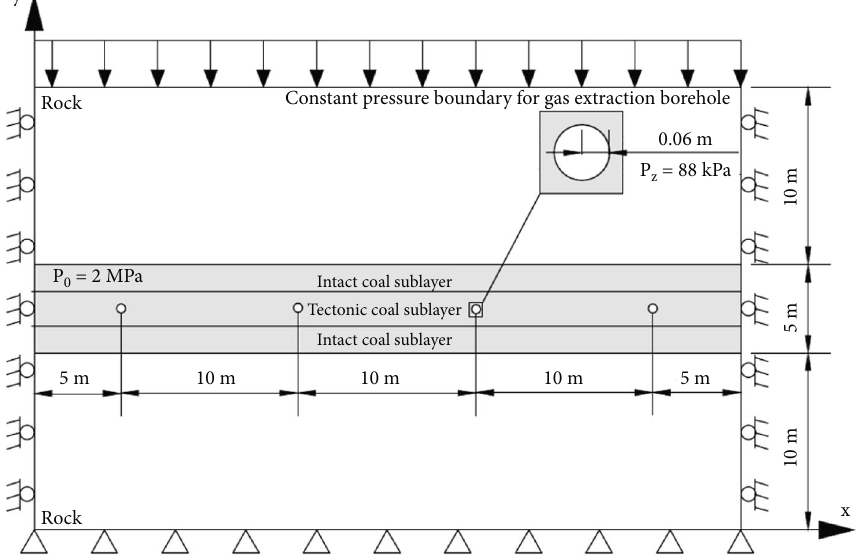
Figure 2: Geometry for gas migration in the combined coal